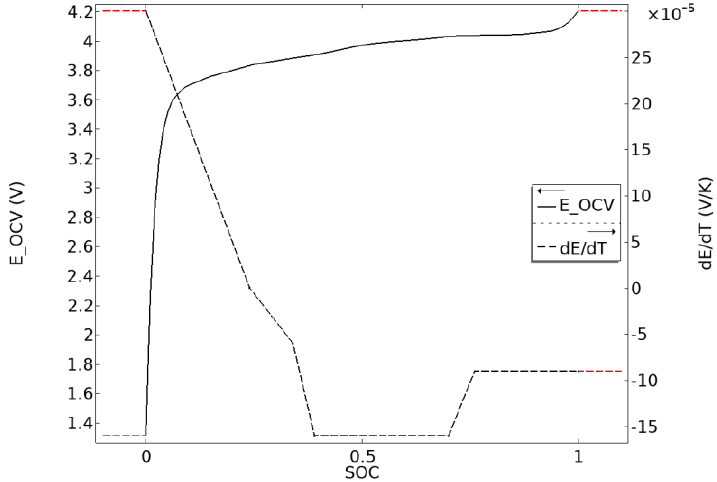
Figure 4. Curves of E OCV vs. SOC at the reference temperature and of the SOC derivative with respect to the reference temperature vs. the SOC.